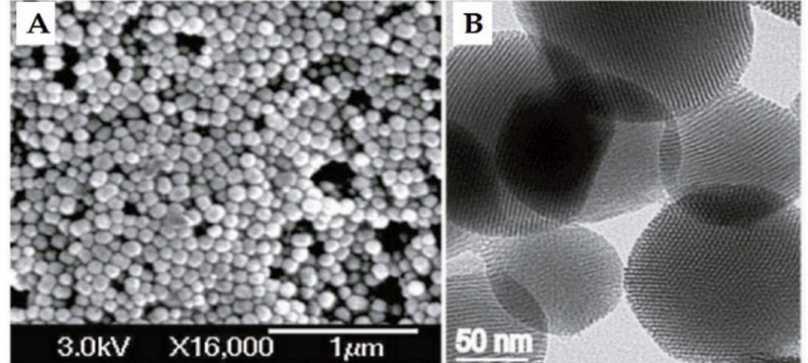
Figure 3. ( A ) Scanning electron microscopy (SEM) and ( B ) transmission electron microscopy